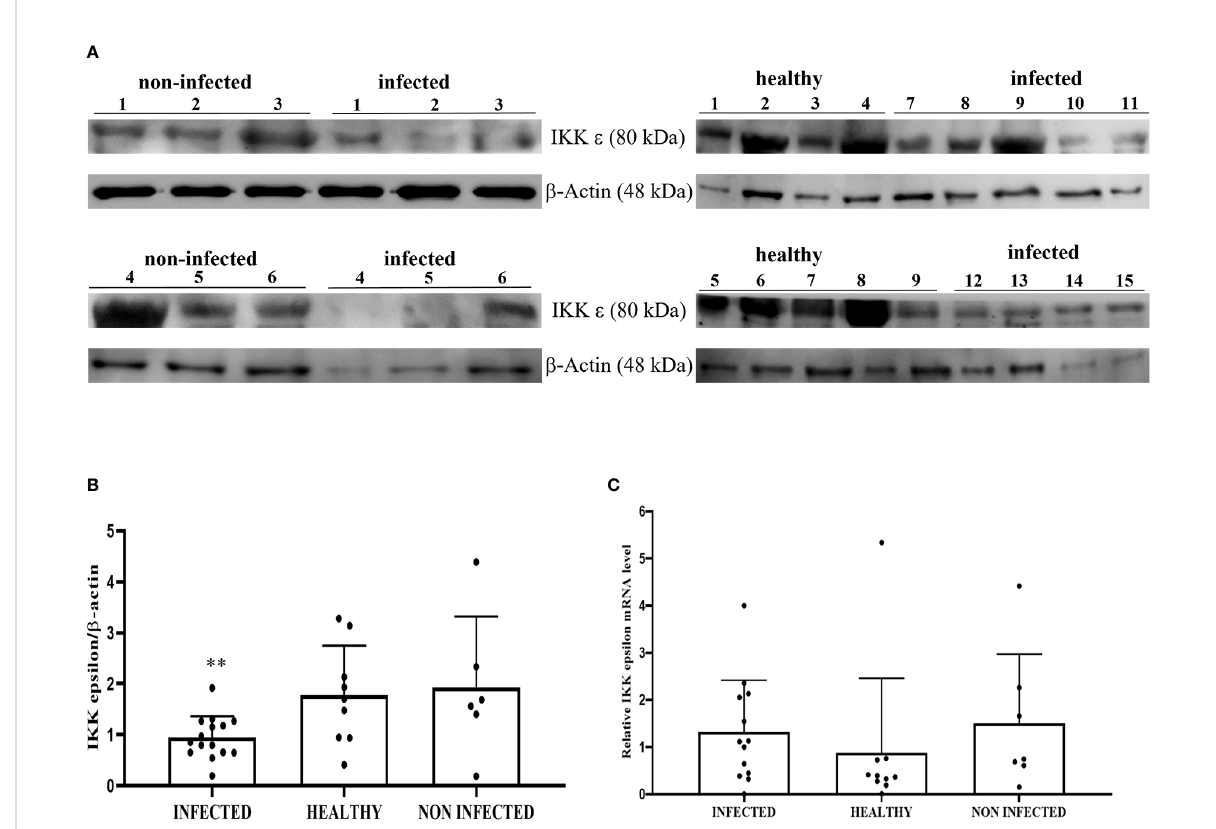
FIGURE 8 (A) Western blot analysis of total IKK e protein in infected, non-infected, and healthy bladder samples and (B) Densitometric analysis of IKK e protein relative to b -actin protein level (**p ≤ 0.01). Plots present values found for each sample performed in triplicate. (C) RT-qPCR analysis of IKK e mRNA levels in infected, non-infected, and healthy bladder samples, respectively. There was no statistically signi fi cant variation in IKK e mRNA expression level in diseased bladder tissue compared with both non-infected and healthy bladder